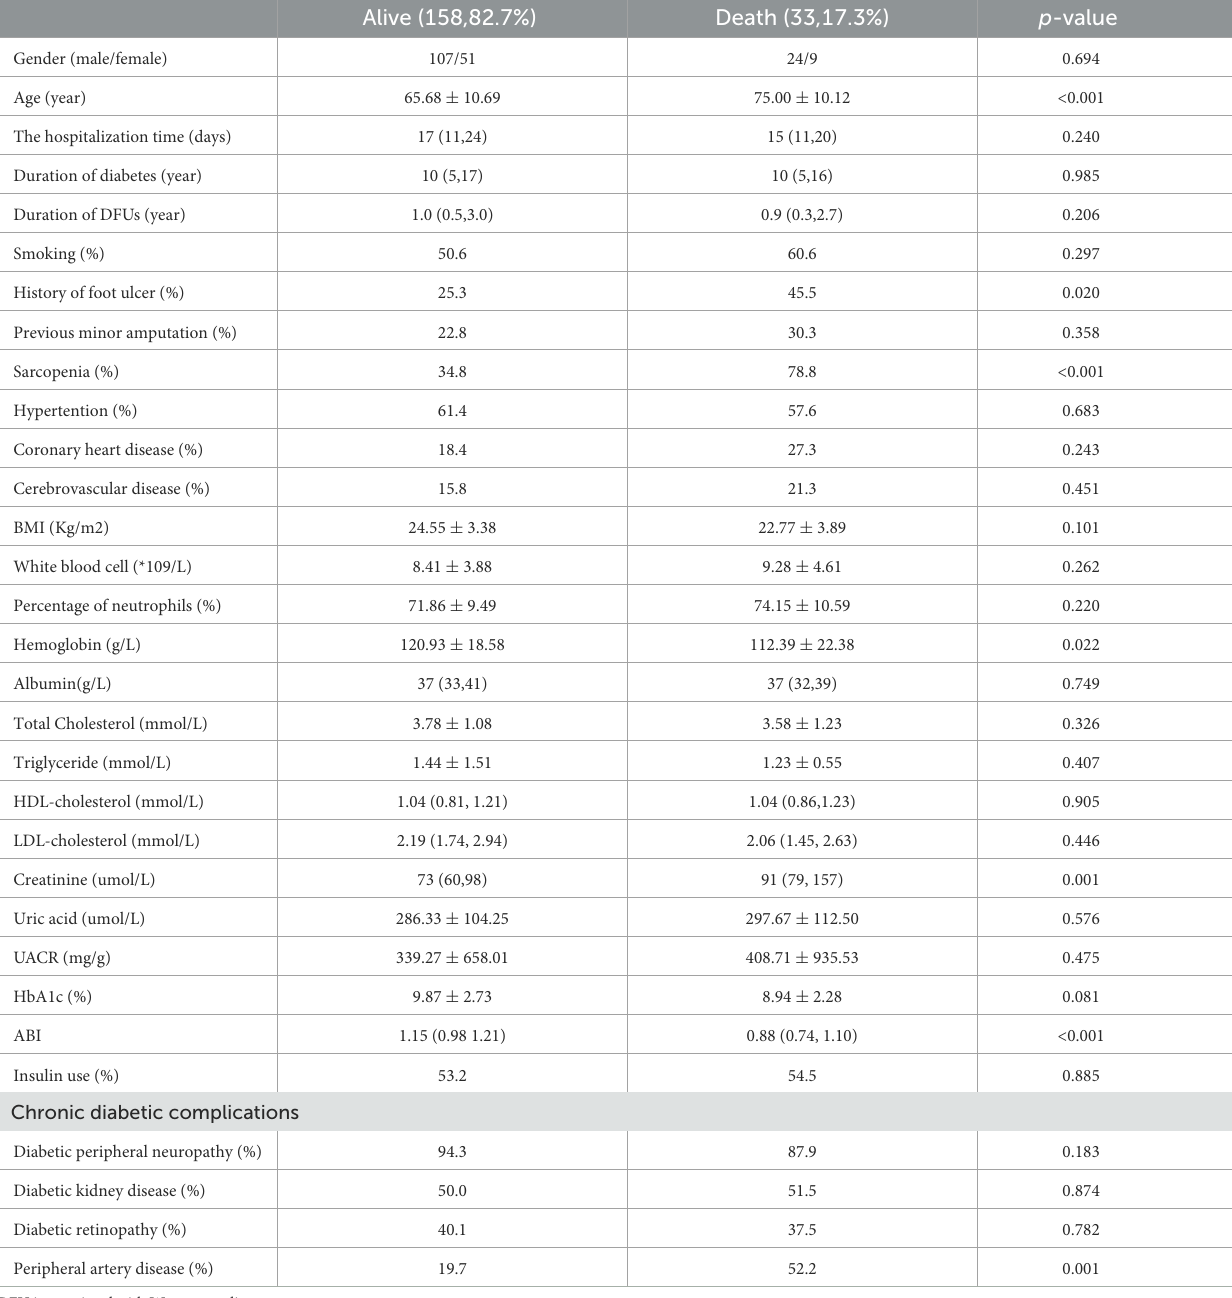
TABLE 1 Baseline clinical and biochemical characteristics of the survival and death group of patients with diabetic foot ulcers. Alive (158,82.7%) Death (33,17.3%) p -value